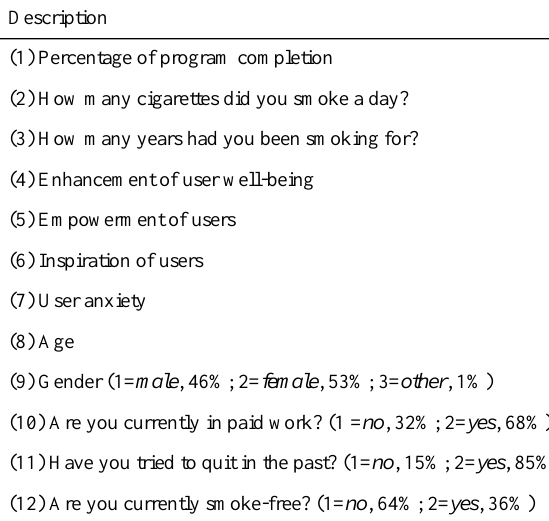
Table 2. Survey respondents: descriptive statistics. Likert scale anchors for users’ well-being, empowerment, inspiration, anxiety was from 1=not at all to 7=very much .